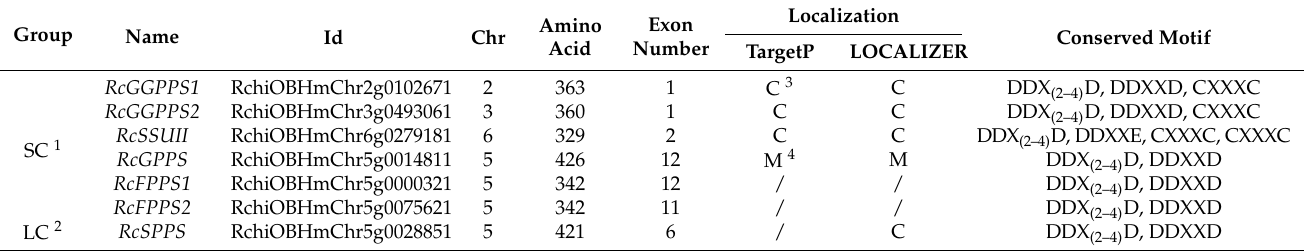
Table 1. Members of full-length RcTPT genes and their sequence characteristics.